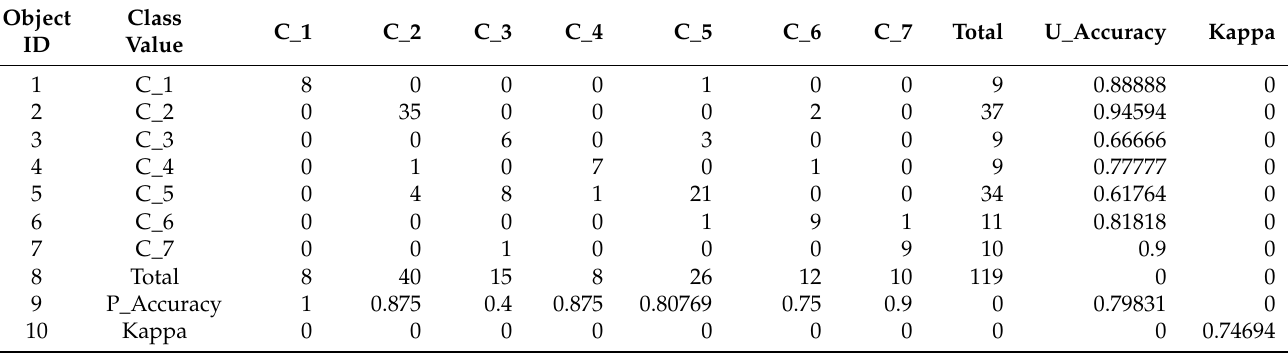
Table 3. Confusion Matrix (RT method).